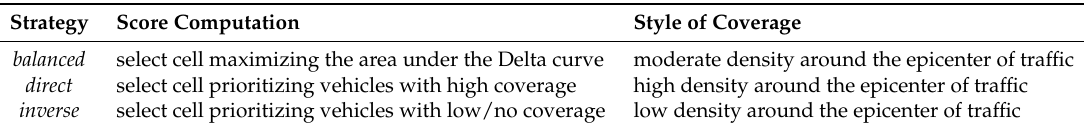
Table 1. Summary of